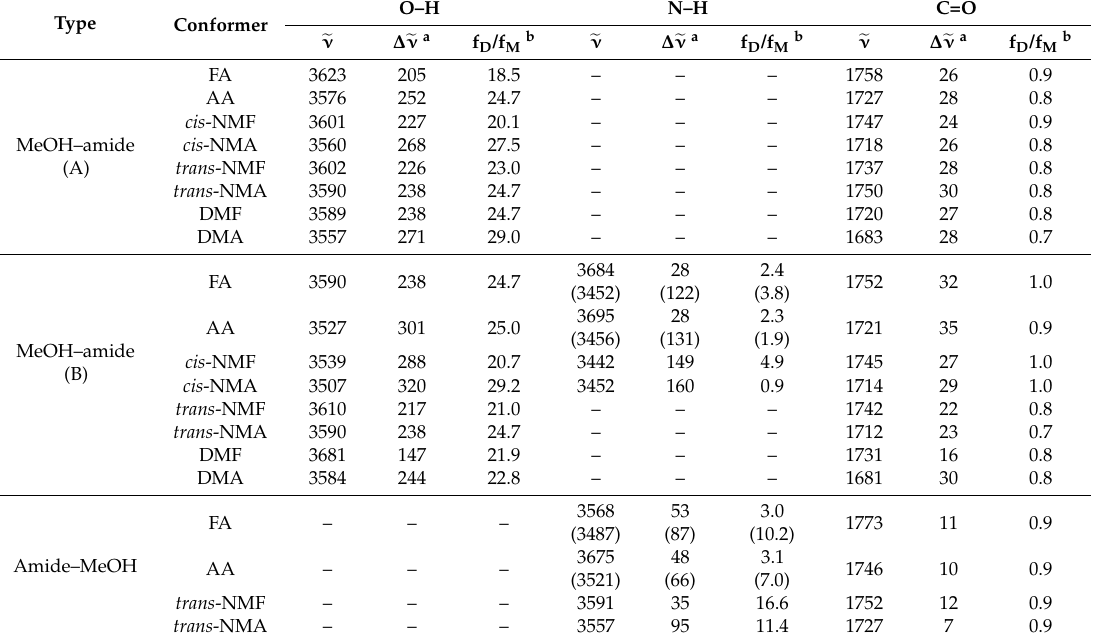
Table 3. Calculated bonded OH-, NH- and C=O stretching vibrational wavenumbers and red shifts (in cm − 1 ) of the MeOH–amide and amide–MeOH complexes at the B3LYP-D3/aug-cc-pVTZ level.